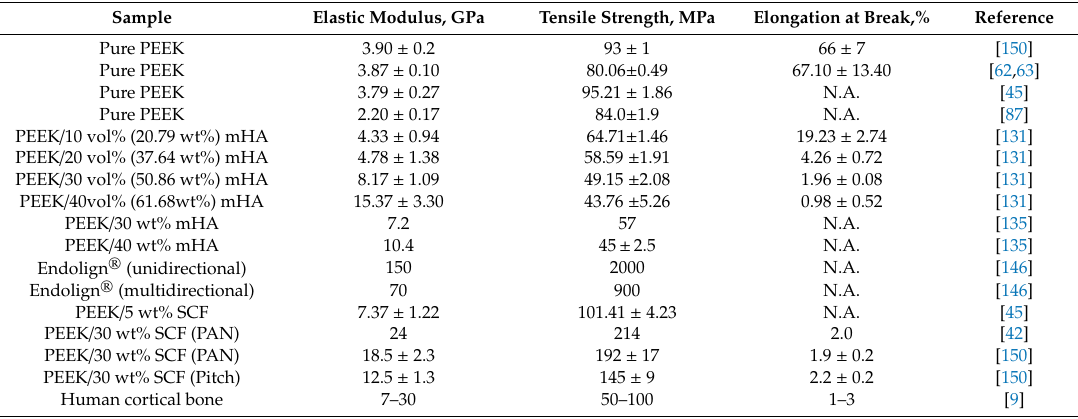
Table 1. Tensile properties of pure PEEK and its